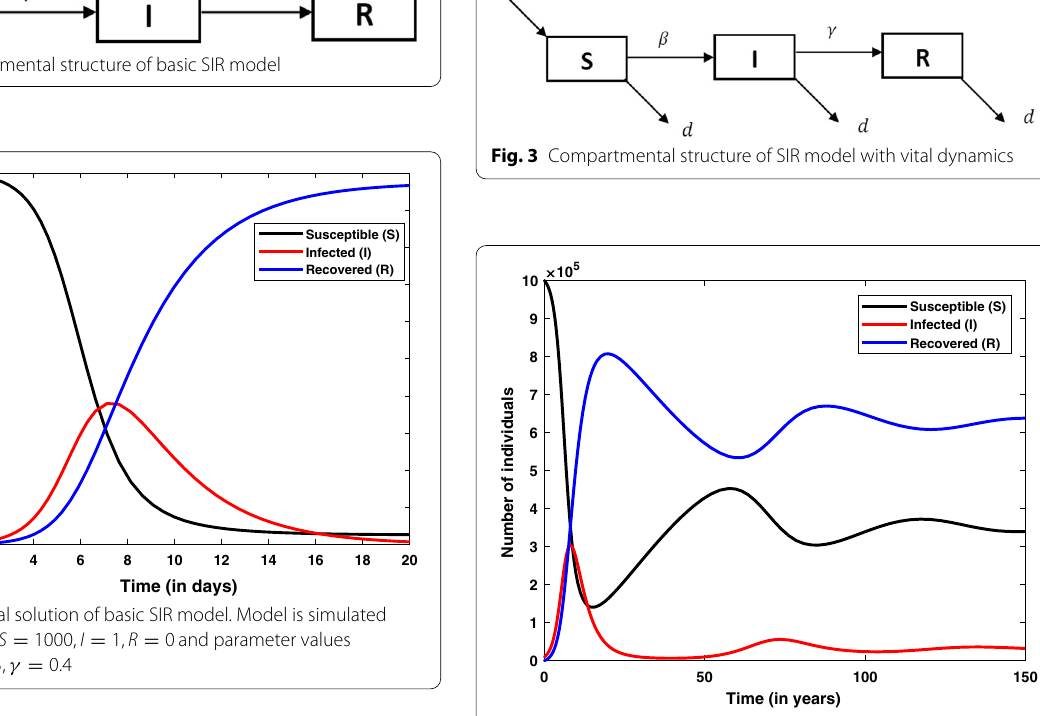
Fig. 4 Numerical solution of SIR model with viral dynamics. Model is simulated for the initial values S = 10 6 , I = 10 4 , R = 0 and parameter values b = 1 / 60, d = 1 / 60, β = 10 − 6 , γ = 1 /